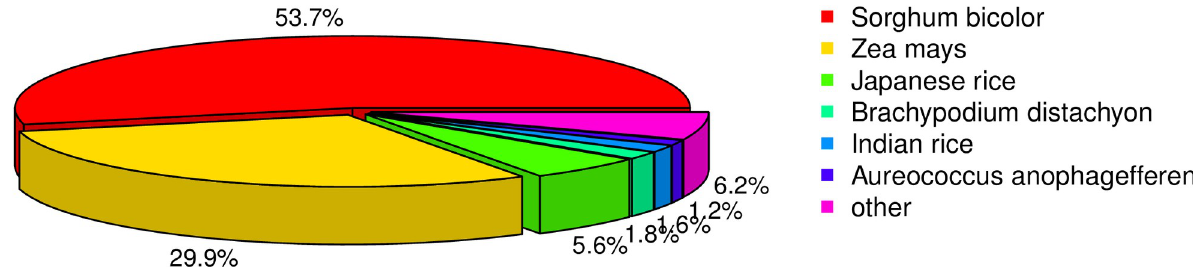
Fig 4. The species distribution based on the BLAST of NR